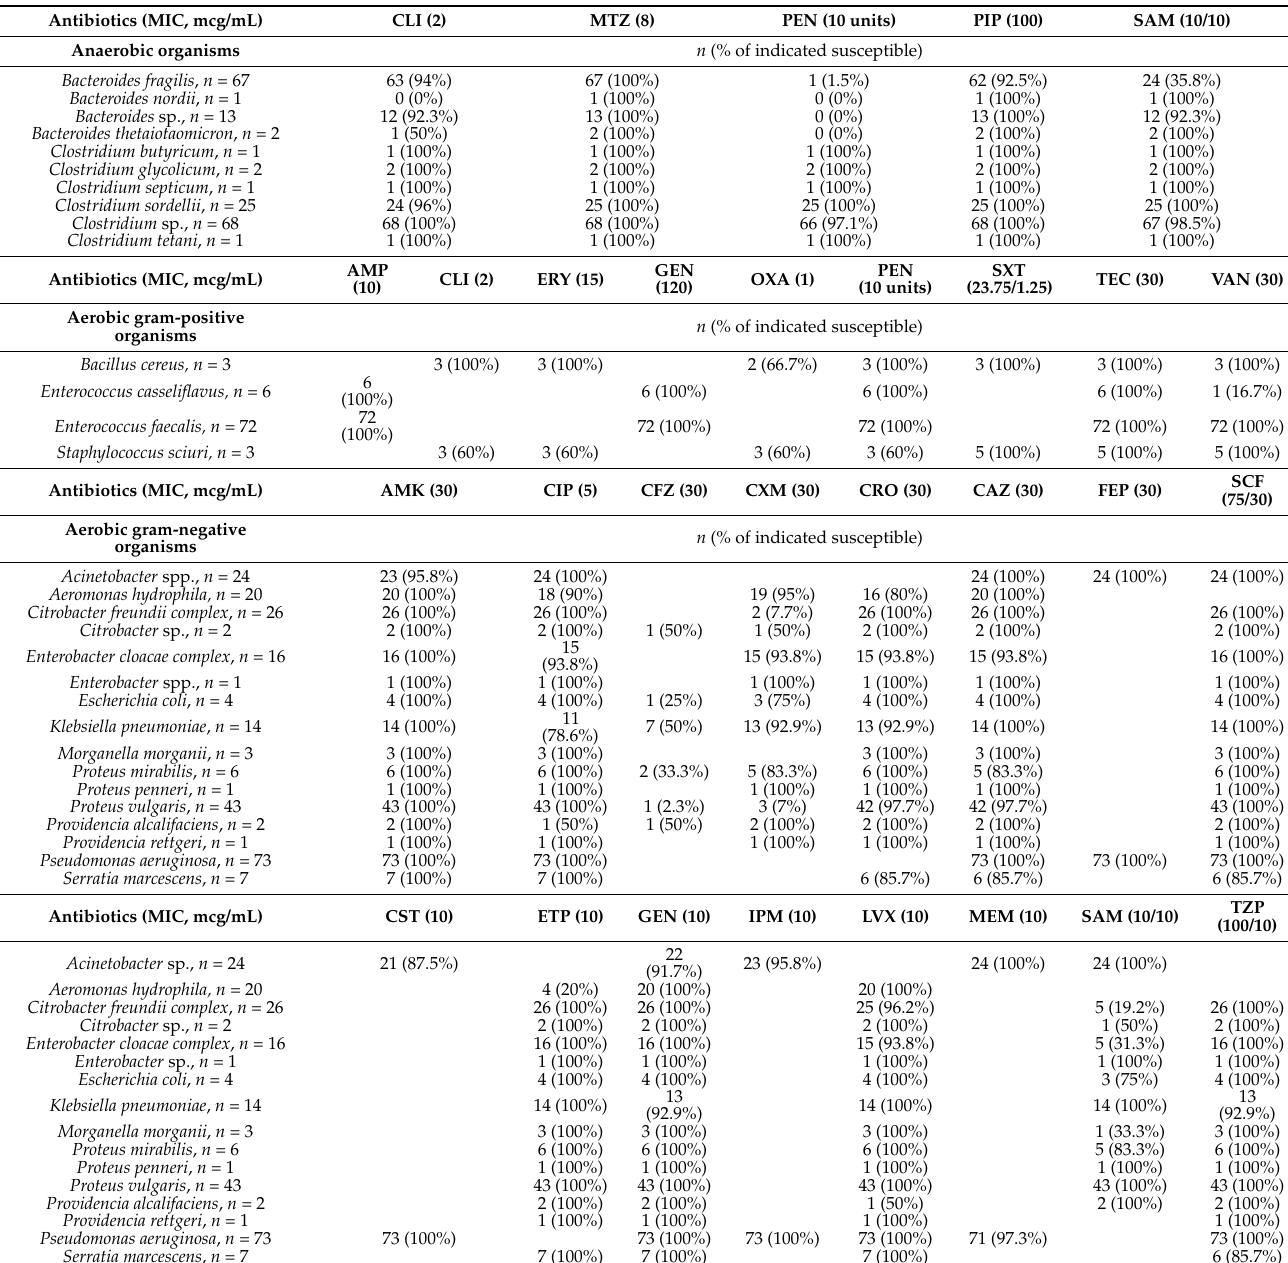
Table 3. Antibiotic susceptibilities of bacteria isolated from oral cavities of